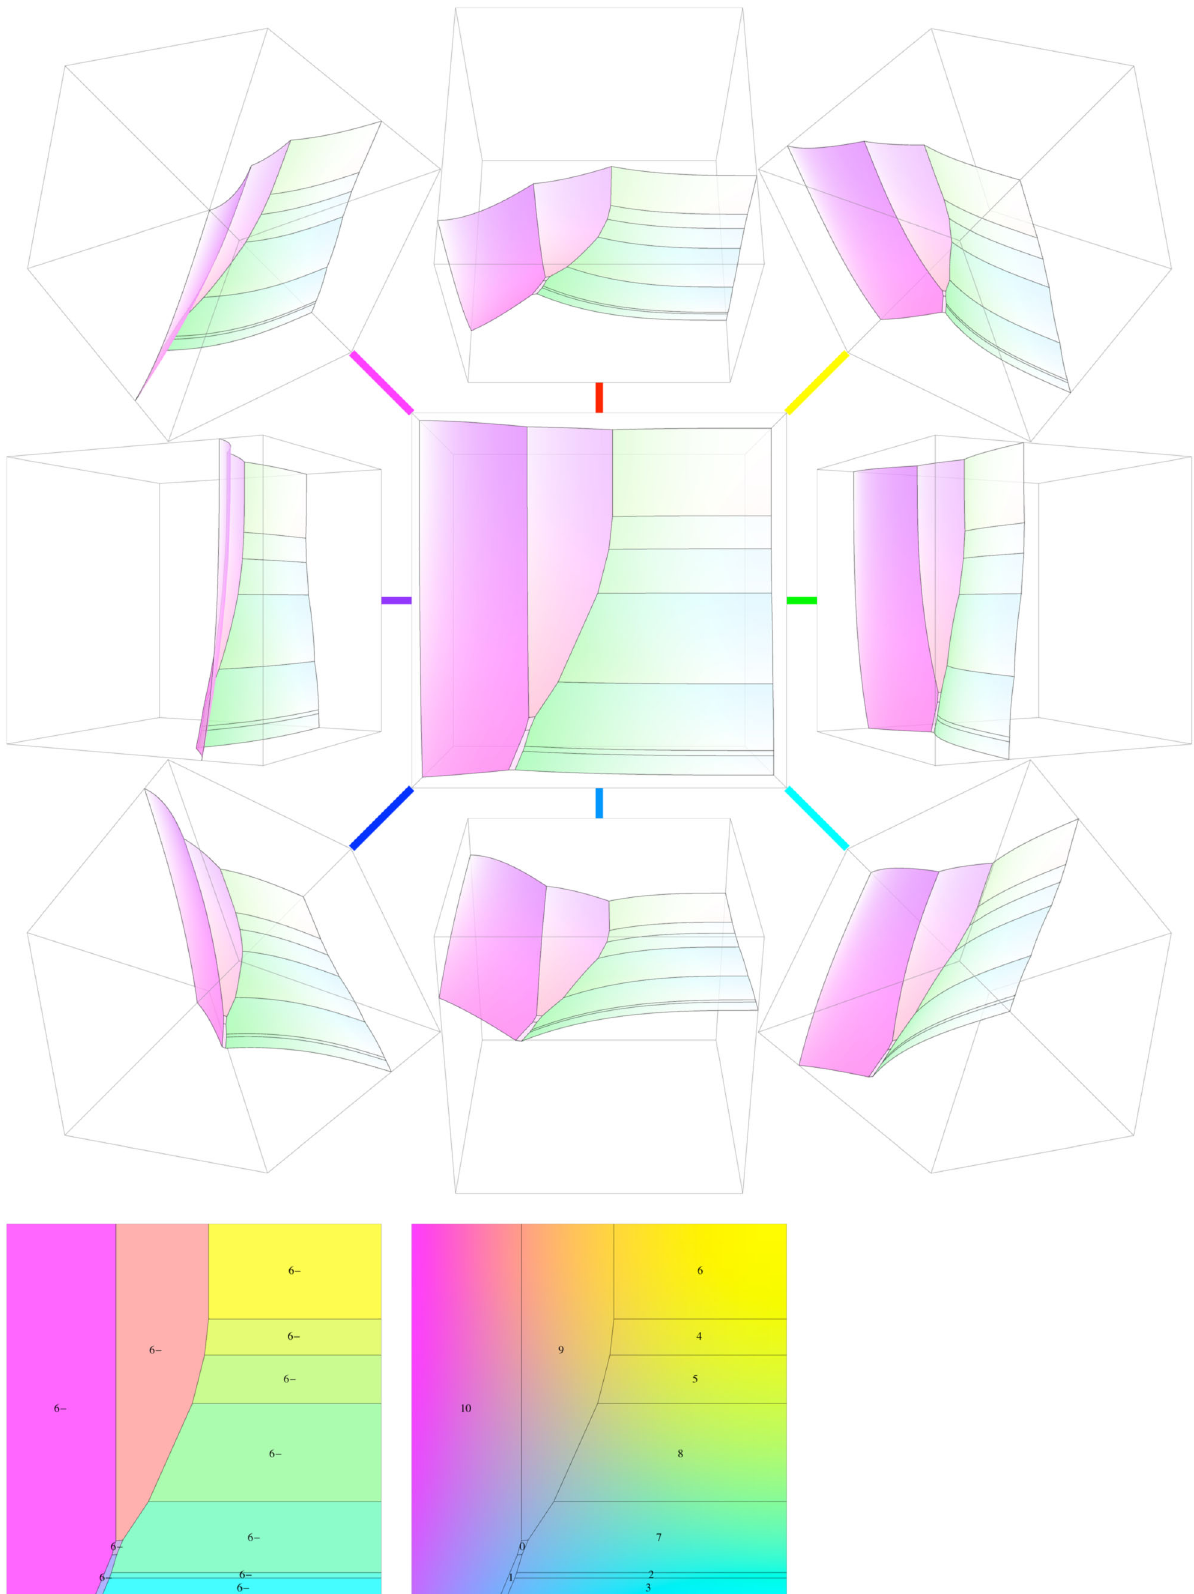
FIG. 5 523-family optimal density surface ( 3 × 3 grid of cubes), parallel contacts (bottom left), face areas, and region size (bottom